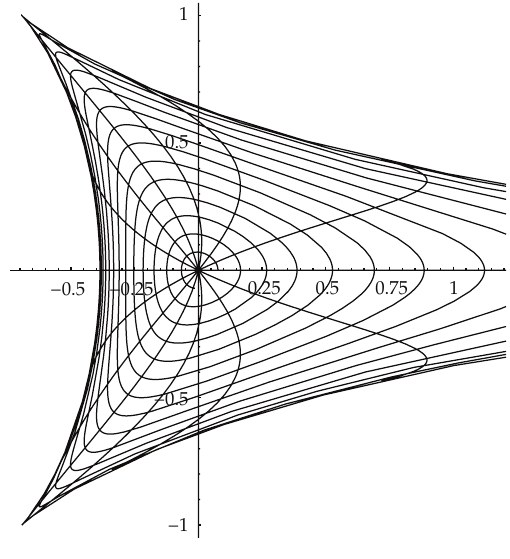
Figure 3: The image of f (cid:3) z (cid:4) (cid:5) − z − 2log | 1 − z |